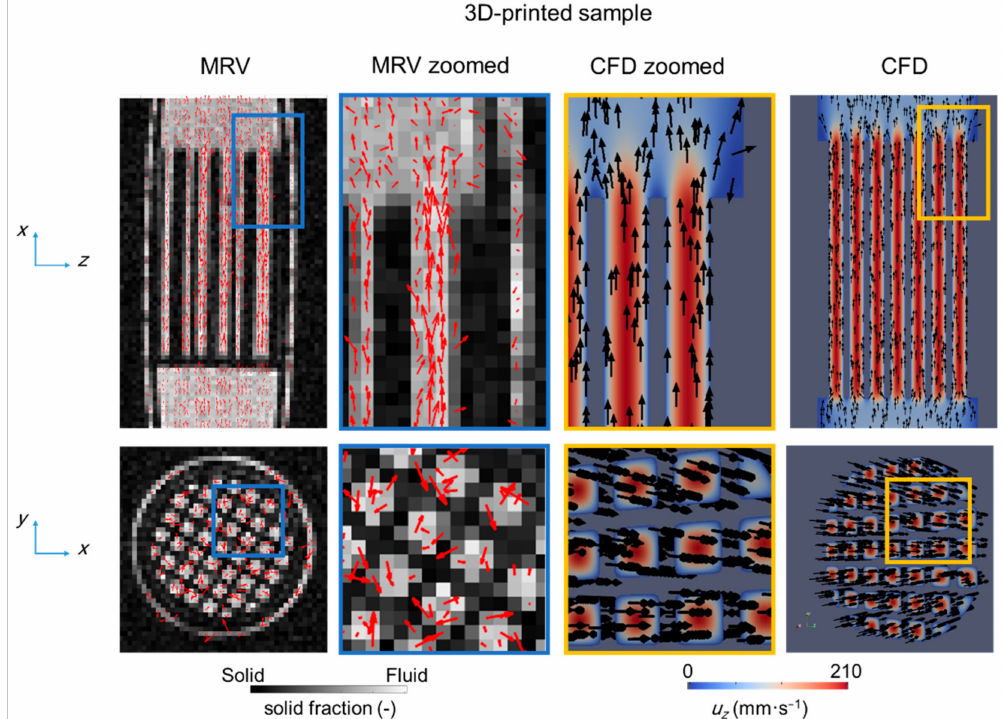
Figure 7. The obtained velocity vectors for the flow rate of 1.5 SL · min − 1 of methane within the 3D-printed monolith from MRV measurements and CFD